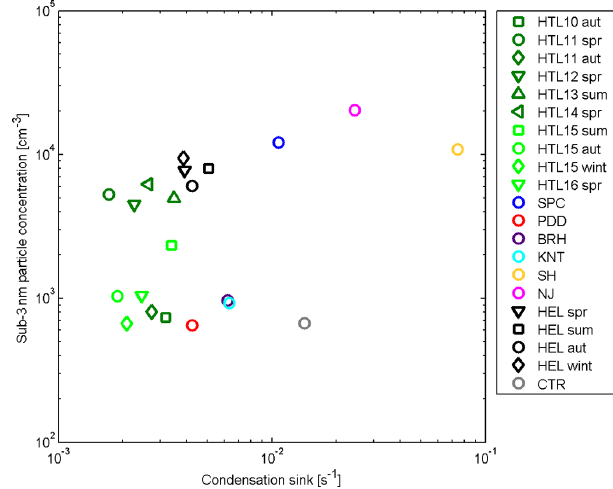
Figure 10. The daytime medians of sub-3nm particle concentration as a function of sulfuric acid concentration in different measure- ment campaigns. Sulfuric acid concentration was calculated from a proxy for all other measurement campaigns except those in Kent, Brookhaven, and Centreville and in Hyytiälä during spring 2011.